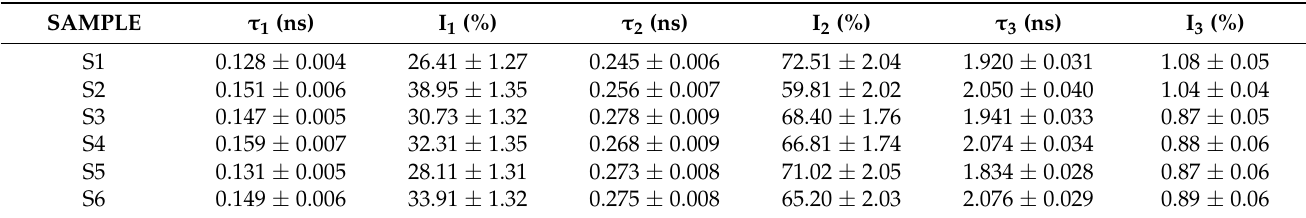
Table 1. Mean positron lifetime values of τ 1 , τ 2 , and τ 3 and their intensities I 1 , I 2 , and I 3 .